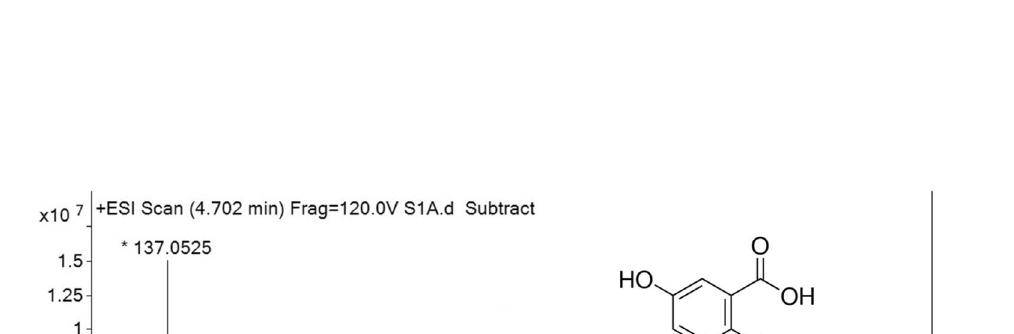
Figure 10. The defense responses that were triggered by B. aryabhattai HKEB treatment are dependent on the JA pathway against the necrotrophic pathogen B. cinerea . ( a ) Disease symptom evaluation in Arabidopsis mutant plants that were treated with HKEB at 72 h post-inoculation. ( b ) The lesion size produced by B. cinerea was determined. The bars represent the mean values and standard errors of the means (n = 10). The experiments were replicated three times.